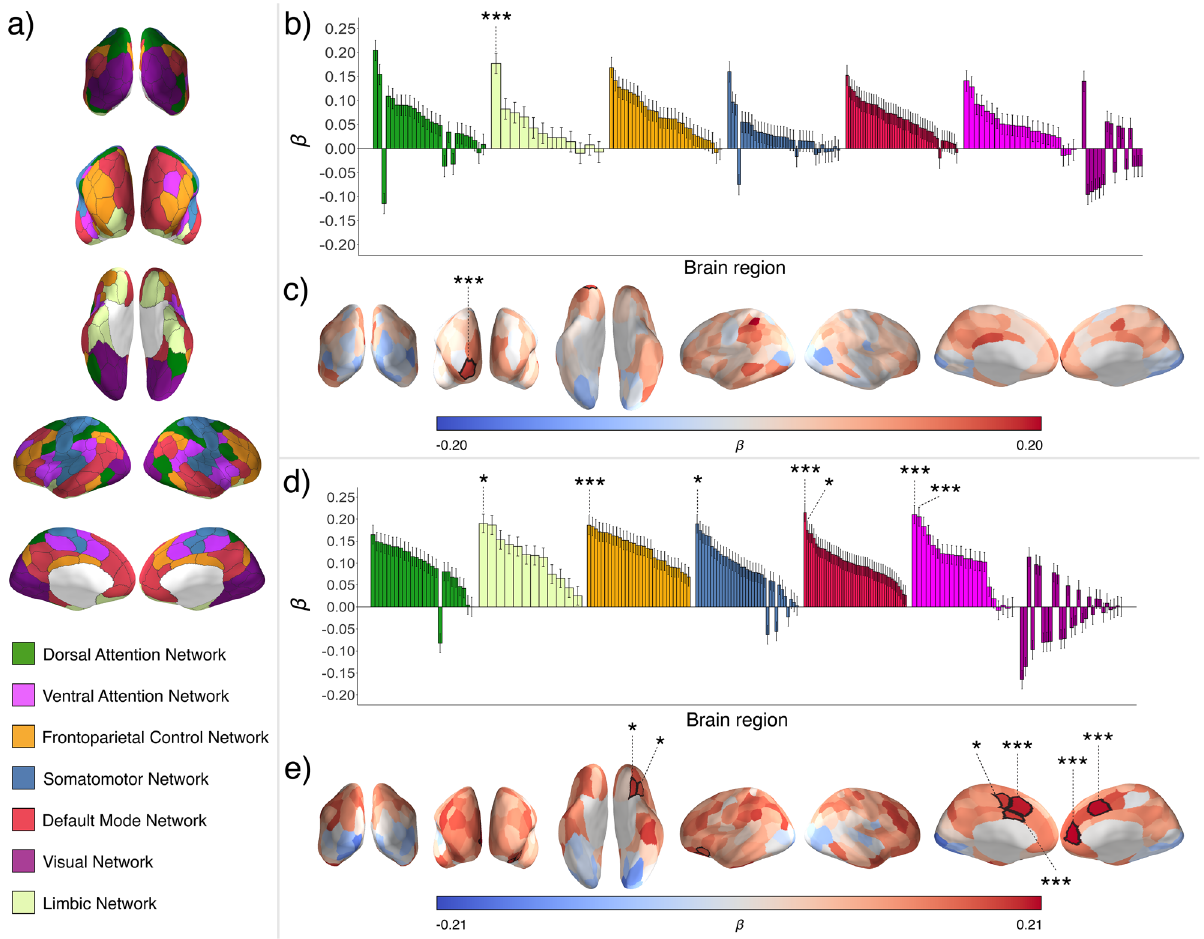
Figure 2. Whole-brain analyses relating personality similarity and neural synchrony. ( a ) Time series of neural responses were extracted from each of 200 parcels spanning the cerebral cortex, as well as 14 anatomically-defined subcortical regions (not shown); each cortical parcel was associated with one of seven functional brain networks. These parcels and networks (annotated by different colors) are visualized on a cortical surface model and shown in posterior (top row), anterior (second row), ventral (third row), lateral (fourth row), and medial (fifth row) views. ( b ) Within each brain parcel, the relationship between personality similarity and NM-Synchrony was assessed using OLS regression. One-sample t-tests confirmed that the distribution of effects (other than the Visual Network) significantly differed from zero. ( c ) Regression coefficients for personality similarity are shown overlaid on the inflated cortical surface. Personality similarity was associated with NM-Synchrony in the right OFC. ( d ) The same statistical procedure was repeated to assess the relationships between personality similarity and NP-Synchrony. One-sample t-tests confirmed that the distribution of effects significantly differed from zero in all but the Visual Network. ( e ) Corresponding regression coefficients are shown overlaid on the cortical surface. Personality similarity was associated with NP-Synchrony in the left cingulate cortex, a medial aspect of the left superior frontal cortex, a medial aspect of the left somatomotor cortex, a region of the right medial prefrontal cortex, a medial aspect of the right superior frontal cortex, a region of the left ventrolateral prefrontal cortex, and a region of the left orbitofrontal cortex. Brain parcels where personality similarity was significantly predictive of neural synchrony are marked by asterisks (* p ≤ 0.05, *** p < 0.001, permutation-tested and